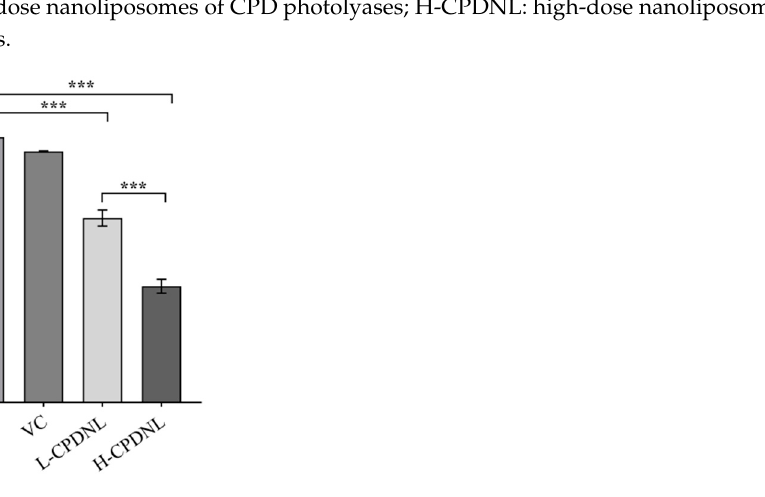
Figure 5. The accumulation of cyclobutane pyrimidine dimers (CPDs, ng/mL). Data represent means ± SEM. *** indicates p < 0.001.